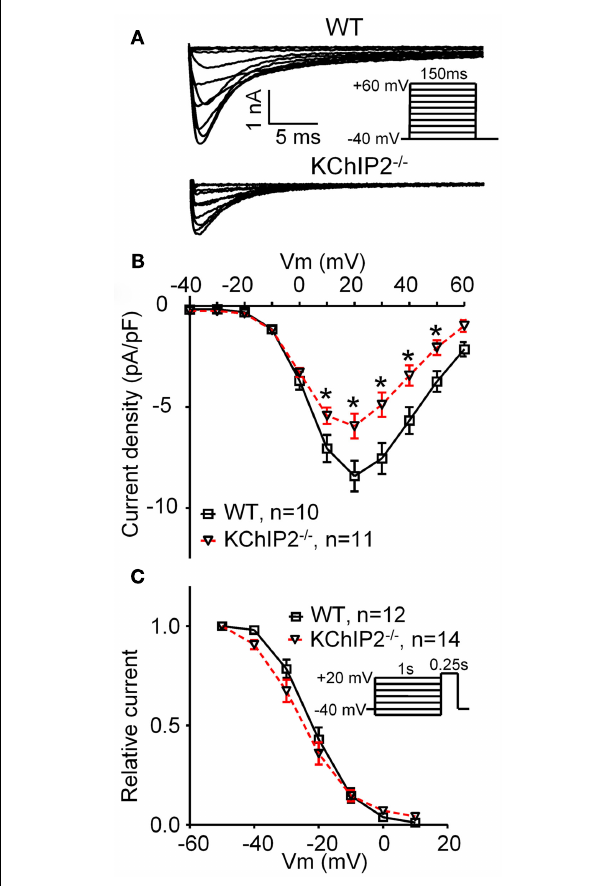
FIGURE 2 | L-type Ca 2 + current in disaggregated cardiomyocytes from wild-type (WT) versus KChIP2 − / − . I Ca,L was recorded at 37˚C in left ventricular cardiomyocytes as the current fraction sensitive to 300 μ M Cd 2 + , as described by Sah et al. (2002) with minor modifications. (A) Representative current traces ofWT and KChIP2 − / − (inset, voltage protocol). (B) Mean peak current densities show a decreased I Ca,L in KChIP2 − / − cardiomyocytes. (C) No changes were found in the steady-state inactivation of I Ca,L inWT versus KChIP2 − / − cardiomyocytes (inset, voltage protocol). Data are reported as mean ± SEM. Statistical significance was evaluated by ANOVA followed by Newman–Keuls’ post hoc test where appropriate. * p < 0.05. Comparable data have been published previously by Thomsen et al.